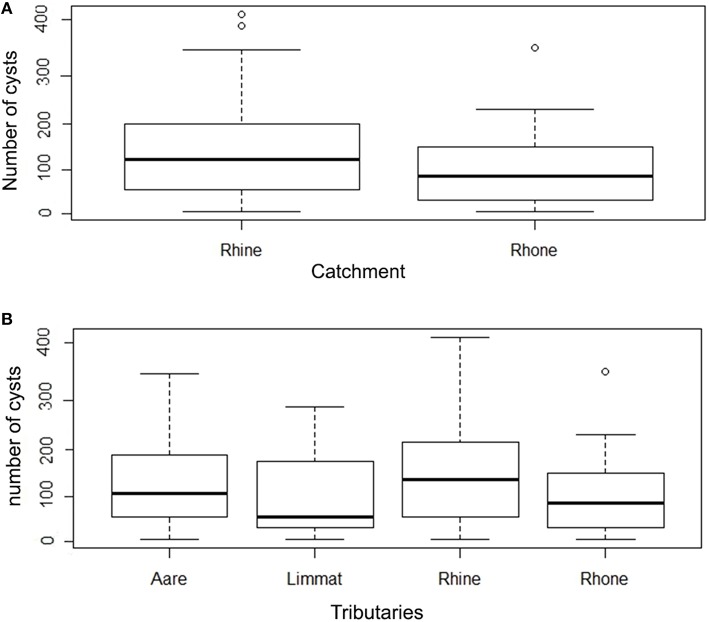
(A) Box plot of number of cysts per gill arch in Rhine and Rhone catchment. (B) Number of cysts per gill arch in tributaries (Aare, Limmat, and Rhine belonging to the Rhine catchment; Rhone belonging to the Rhone catchment) (note the logarithmic scale in the y axis).